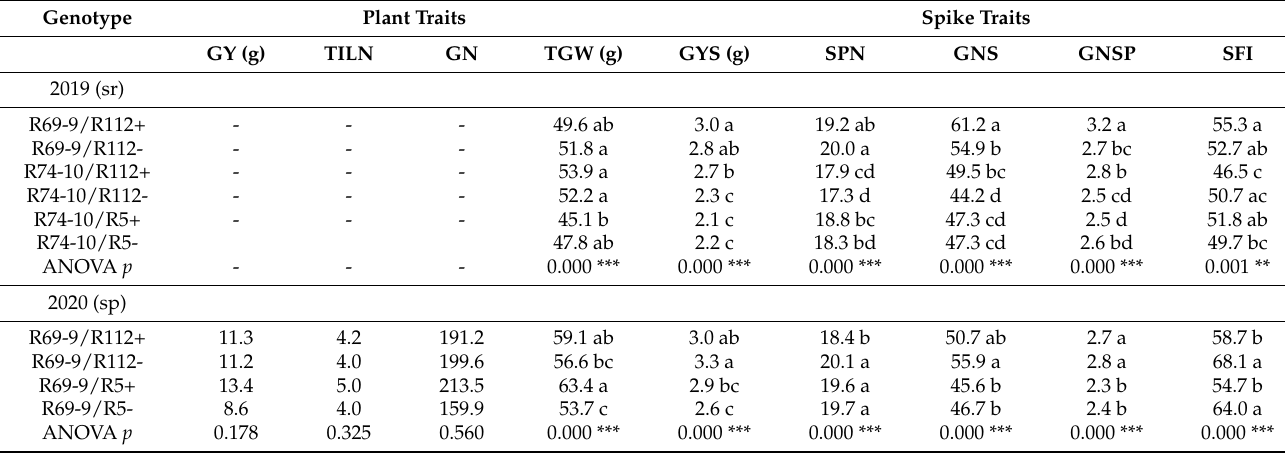
GY, grain yield/plant; TILN, tiller number/plant; GN, grain number/plant; TGW, 1000-grain weight; GYS, grain yield/spike; SPN, spikelet No./spike; GNS, grain No./spike; GNSP, grain No./spikelet; SFI, spike fertility index.; sr, spike row; sp, spaced plants; letters in each column correspond to the ranking of Tukey test at 0.05 level for Genotype effect; ** and ***, significance at p < 0.01 and 0.001,